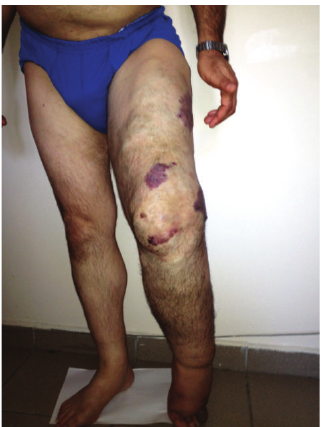
Figure 1: The appearance of the lower extremities of the patient showing shortness and thickness of the left leg with variceal enlargement of the veins and